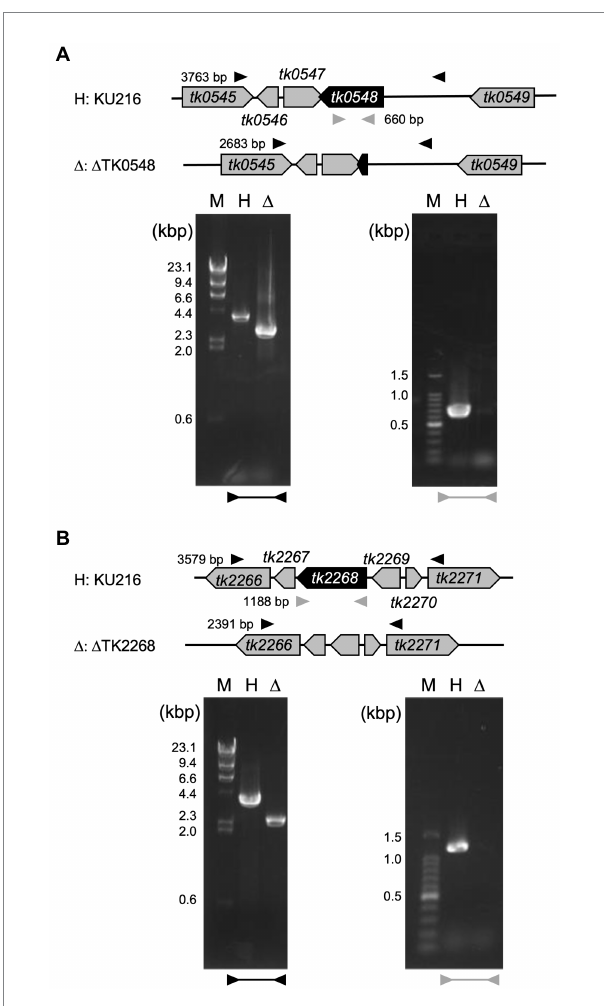
FIGURE 5 Confirmation of TK0548 (A) and TK2268 (B) gene disruption by PCR. Predicted gene loci before and after gene disruption are shown above the gels. Arrowheads indicate the position of primers outside the homologous regions used for recombination (black) and inside the coding regions (gray). Amplified fragments were subjected to agarose gel electrophoresis along with DNA markers (M). H, host strain KU216; Δ , gene disruption strains.